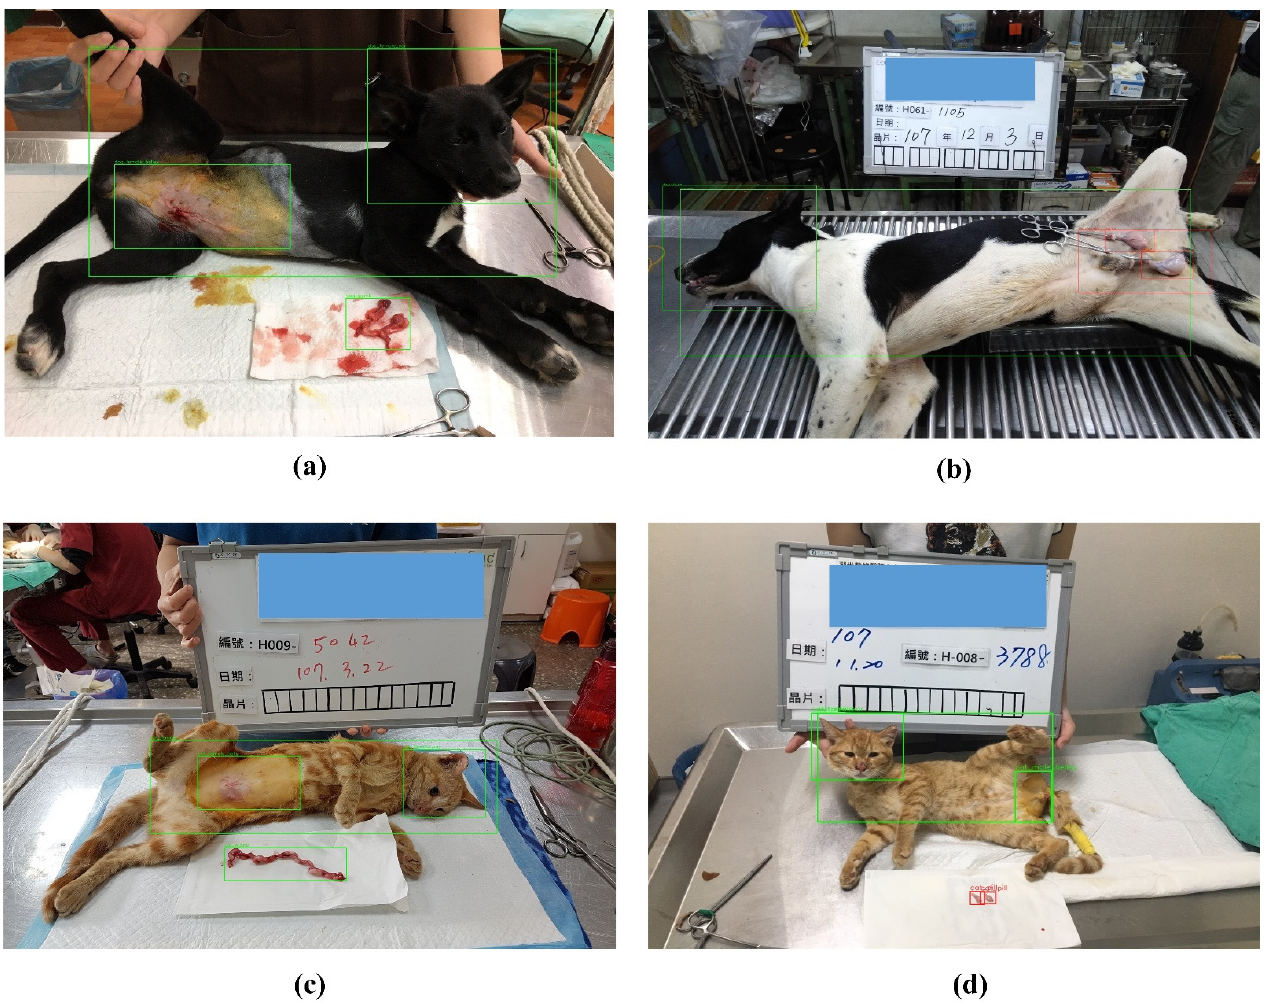
Figure 5. Samples for neutered pictures of Female Dog’s ( a ), Male Dog’s ( b ), Female cat’s ( c ) and Male cat’s ( d ) character- istics.